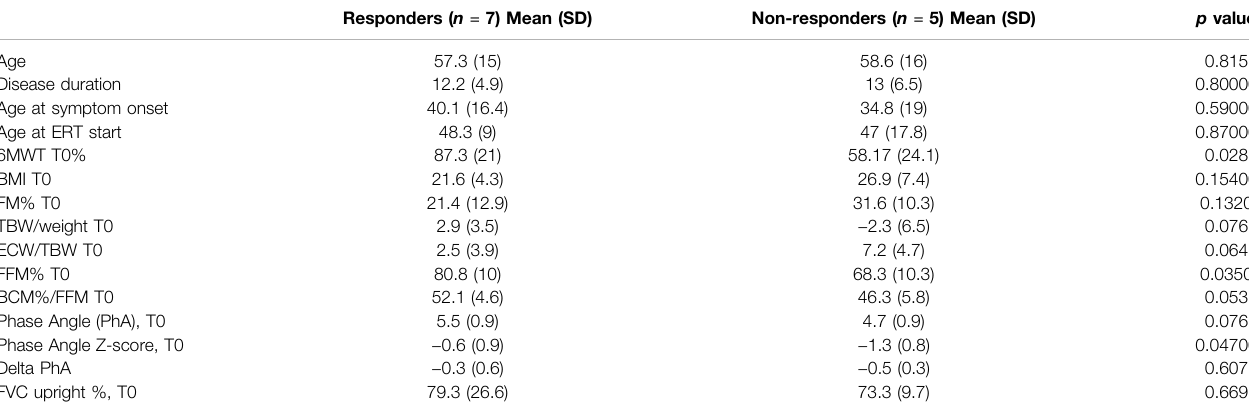
TABLE 2 | Differences in basal nutritional parameters between responders and non-responders a